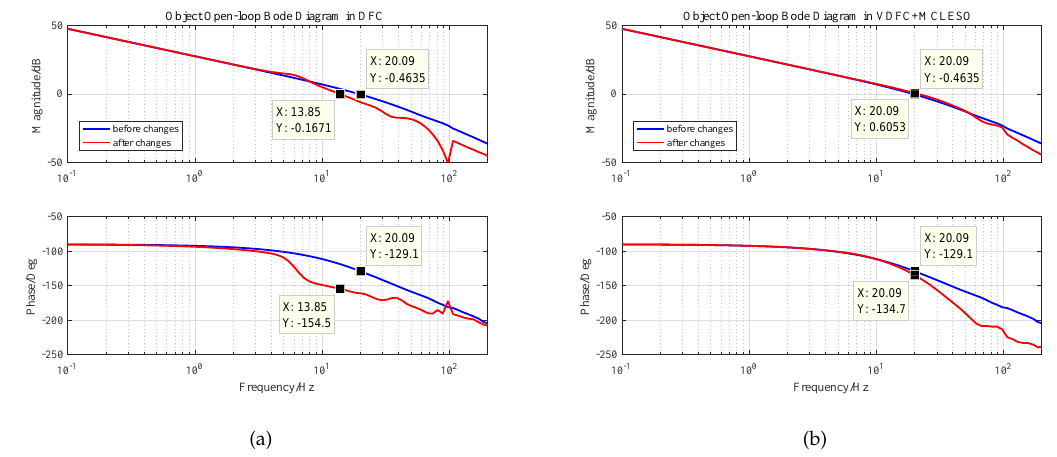
Figure 5. System open-loop Bode diagram before and after changes: ( a ) in DFC. ( b ) in VDFC with